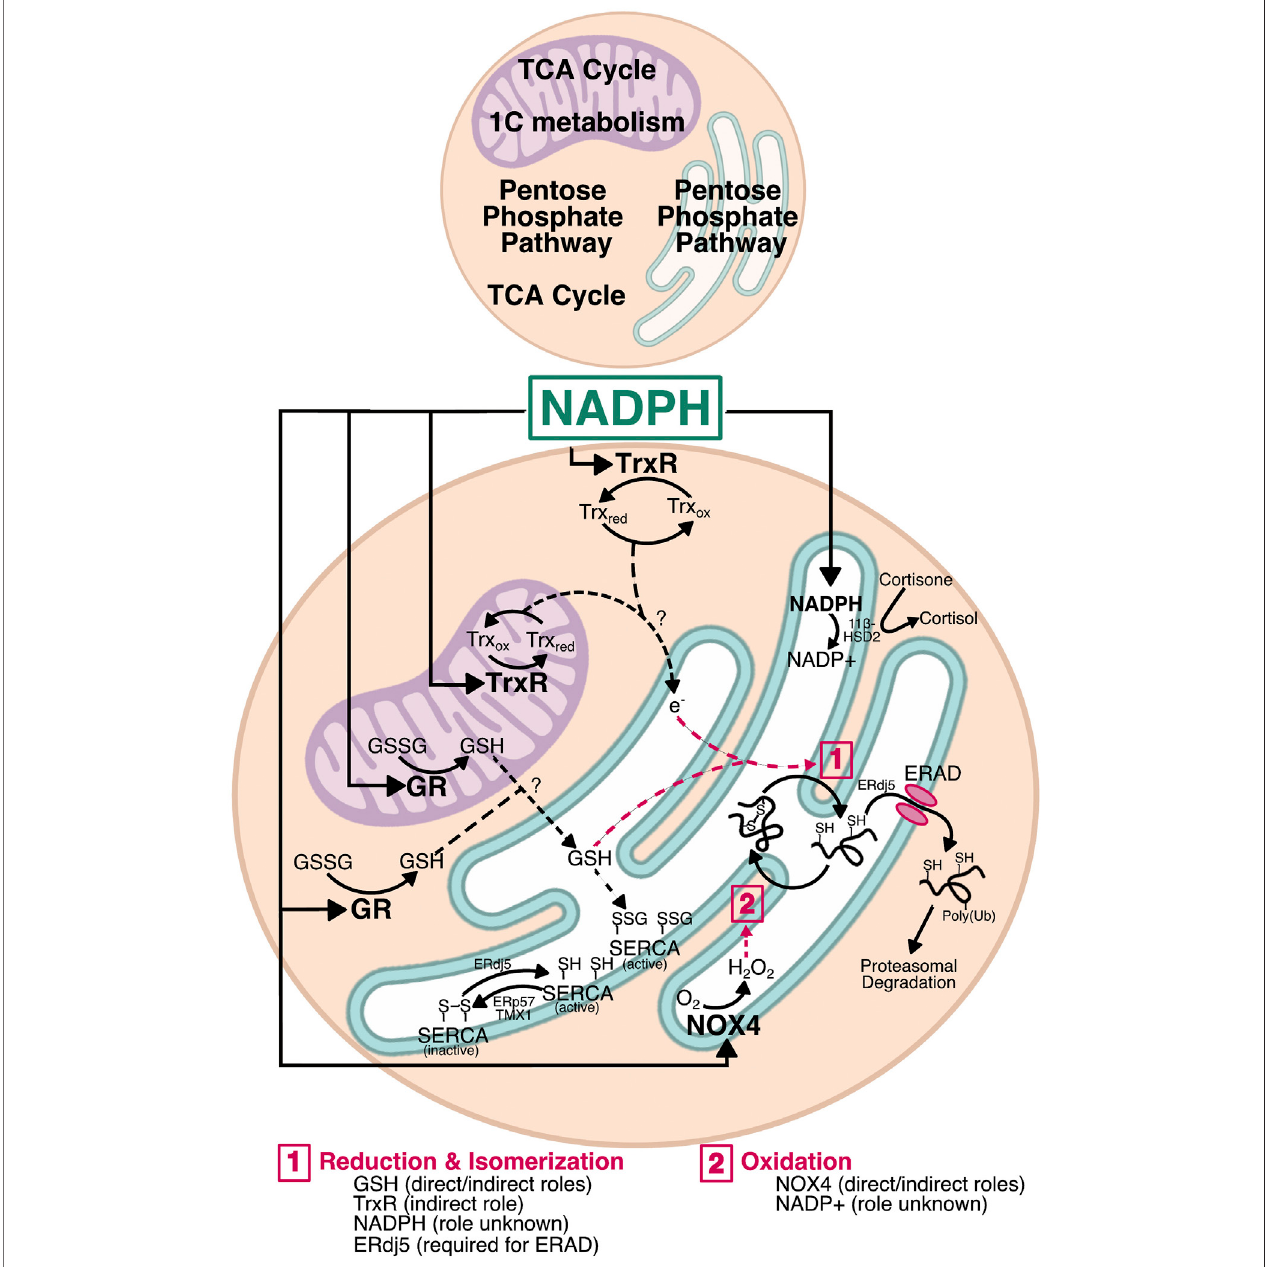
FIGURE3| MechanismsbywhichNADPHcouldaffect ERfunction.NADPHisamajorfactor inredox homeostasis. Inboth thecytosoland mitochondria,NADPH is used by glutathione reductase (GR) and thioredoxin reductase (TrxR). Generation of GSH by GR in either compartment could move into the ER and alter the oxidizing environment by interacting with PDI family members for disul fi de reduction, whether during isomerization or for retrotranslocation. Similarly, TrxR has the potential to transferelectronsacrosstheERmembrane — byacurrentlyunknownmechanism — forreductionofnon-nativedisul fi desduringisomerization.ReductionbyERdj5 isalsorequiredforproteinretrotranslocationduringERAD.GSHandelectronsentering via theTrxpathwaymayalsoin fl uenceERcalciumbyregulatingSERCA.SERCA is activated by reduction (ERdj5) and inactivated by oxidation (ERp57 and TMX1), and is also activated by S-glutathionylation, providing a direct role for glutathione in calcium homeostasis. Finally,NADPH oxidase 4 (NOX4) uses cytosolic NADPH togenerate H 2 O 2 in the ER lumen. This H 2 O 2 could be used by ER-resident PRDX4 and GPx7/8 during PDI reoxidation as shown in Figure 1 . The H 2 O 2 produced by NOX4 also has the potential to regulate SERCA redox and calcium homeostasis. Though the NADPH pool in the ER lumen appears uncoupled from the protein folding machinery, it nonetheless plays a role in overall redox and regulates steroid activation by 11 β -hydroxysteroiddehydrogenase (11 β -HSD). Whetherthere arereductases thatuse NADPHin theERlumen remains unknown,and thus aroleforNADPHinprotein folding cannot be fully